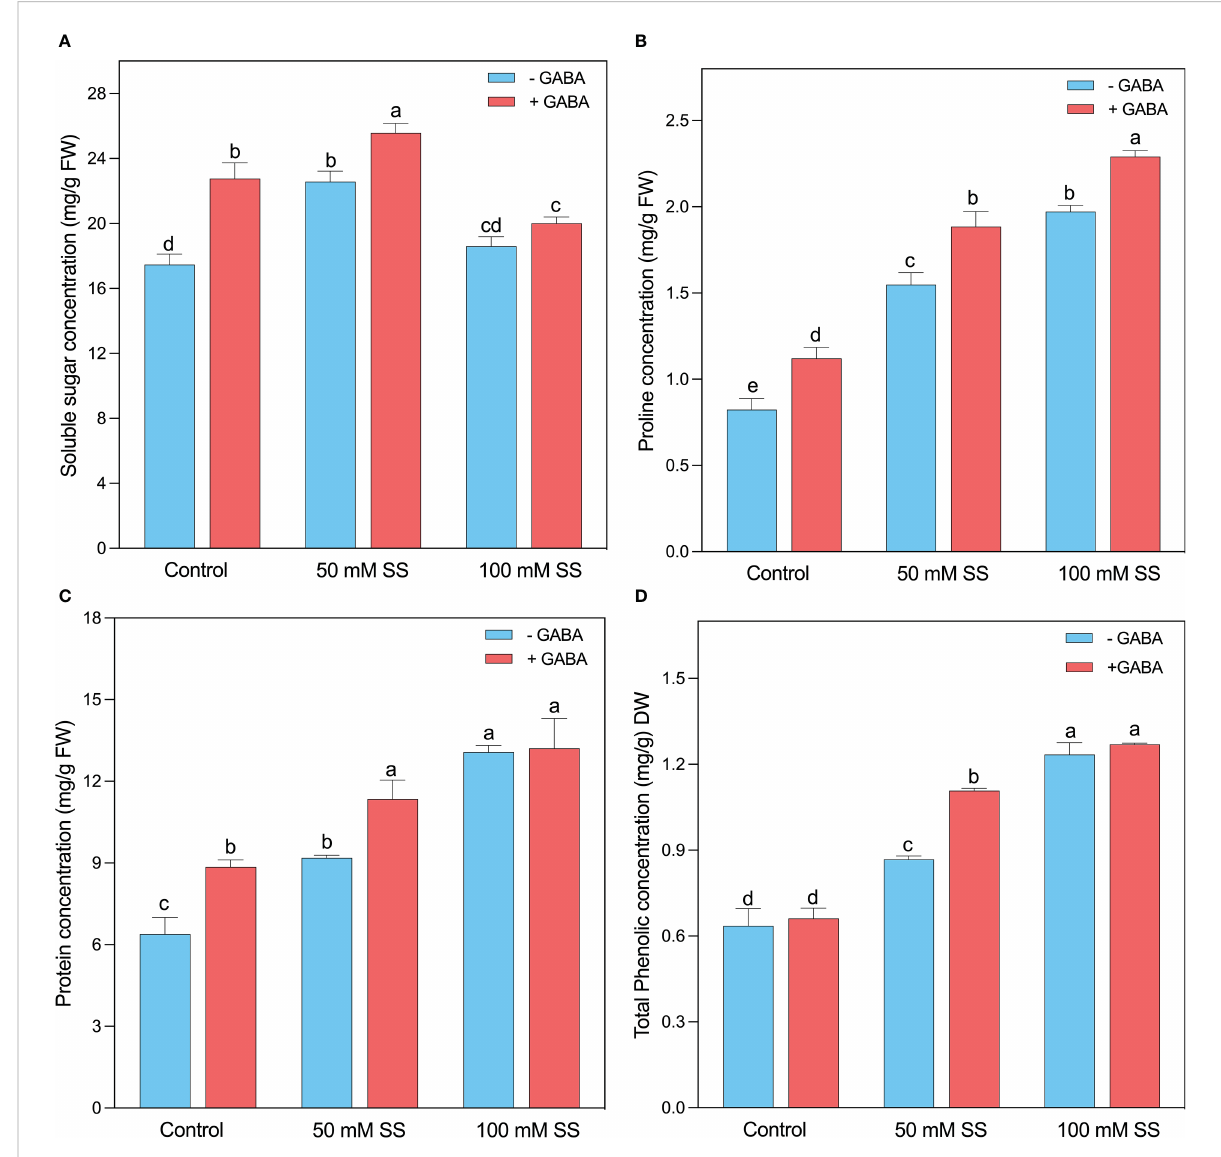
FIGURE 7 Changes in concentrations of (A) sugar, (B) soluble protein, (C) proline, and (D) total phenolic content of mungbean plants under saline stress (SS) and exogenous ( g -aminobutyric acid) treatments. The bars indicate the SE of the mean value, n=3. Different letters above the bars indicate signi fi cantly different values at P <0.05 following Duncan ’ s